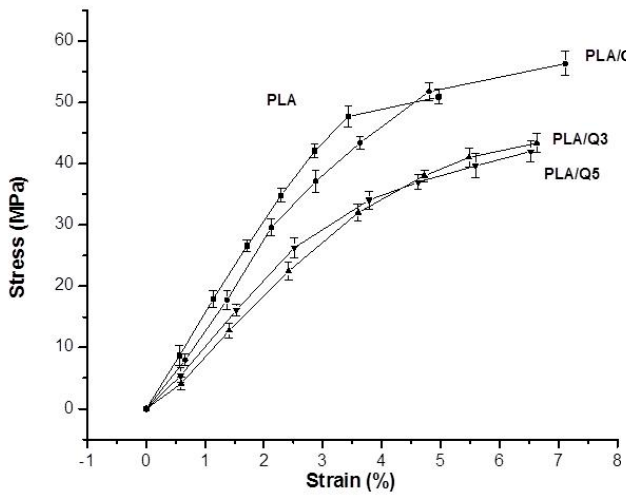
Figure 4. Stress-strain curves in tension of PLA and PLA/chitosan composites with 1 wt % (PLA/Q1), 3 wt % (PLA/Q3) and 5 wt % (PLA/Q5) chitosan. Table 1. Relevant mechanical properties of Polylactic acid (PLA) and Polylactic acid/chitosan composites with different amounts of chitosan.